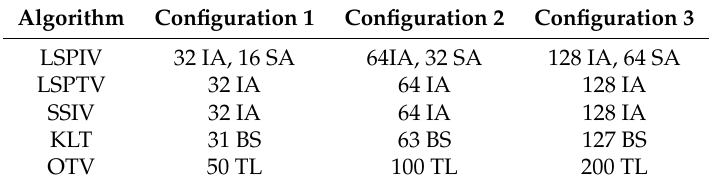
Table 2. Parameters chosen for the sensitivity analysis for all algorithms, all measurements in pixel sizes. IA = Interrogation Area (px), SA = Search Area (px), BS = Block Size (px), TL = Trajectory Length